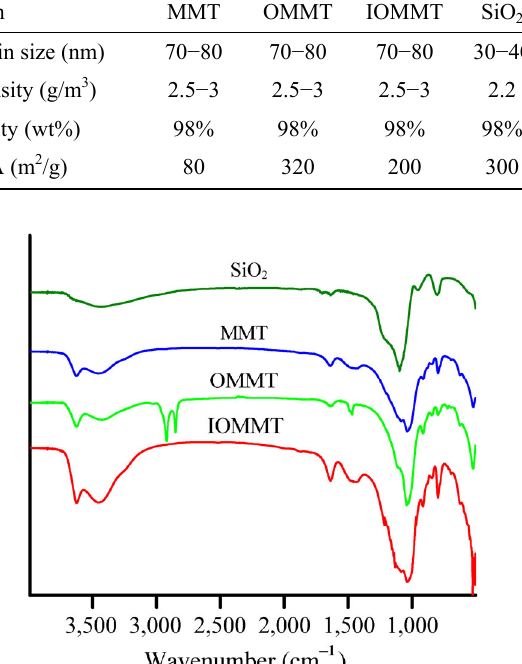
Fig. 1 Fourier transform infrared analysis spectra of the MMT, OMMT, IOMMT and SiO 2